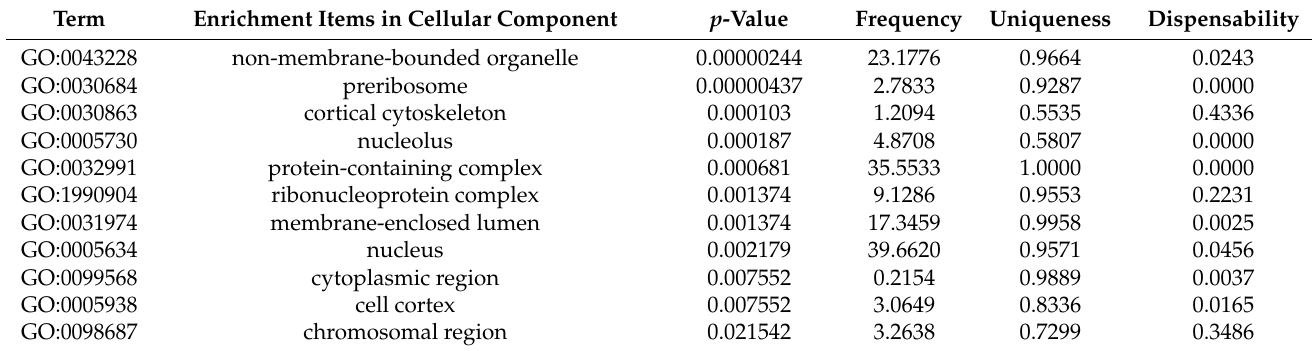
Table 4. Non-redundant enrich items in cellular component of gene ontology analyzed by